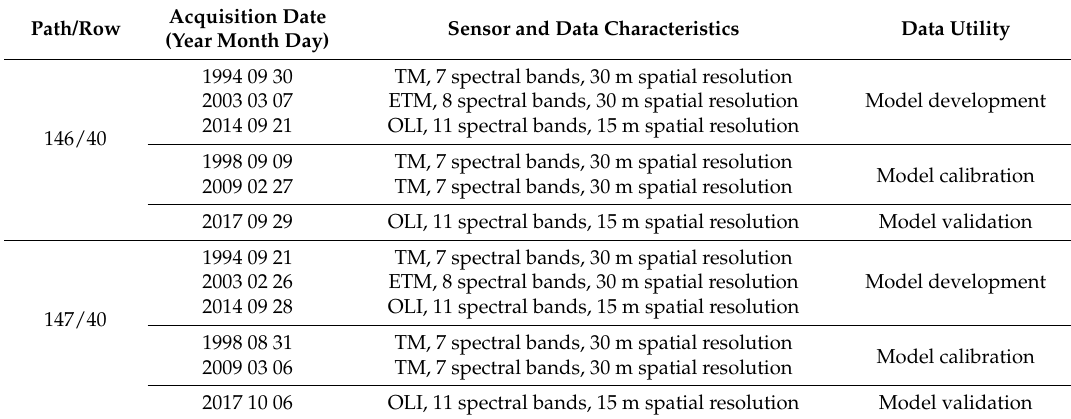
Table 1. Landsat images collected in this